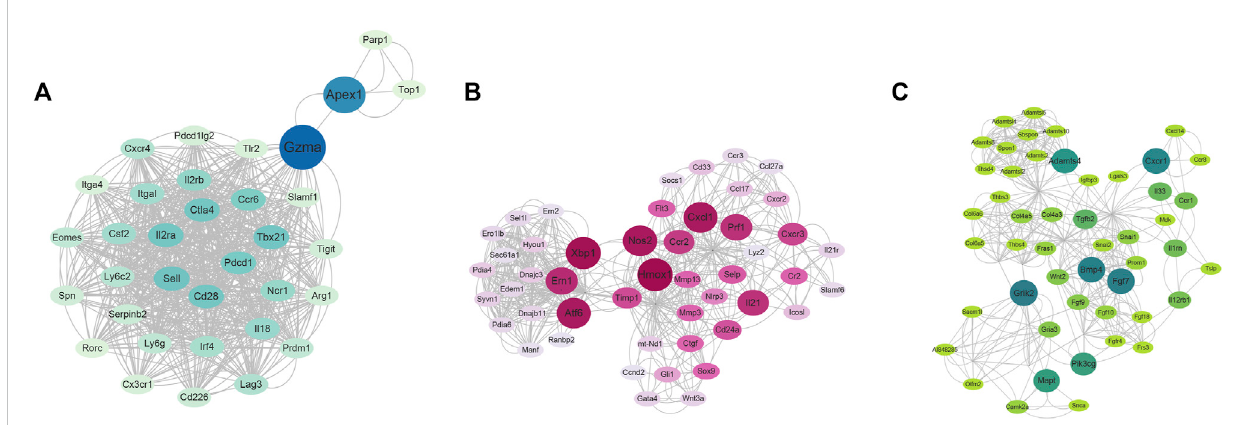
FIGURE 6 The clusters using MCODE via Cytoscape software based on RNA-seq results. (A) The cluster 2. (B) The cluster 3. (C) The cluster 4. (The nodes color and size were arranged by betweenness value, cutoff = 2, node score cutoff = 0.2, k-core = 2, and max. Depth =